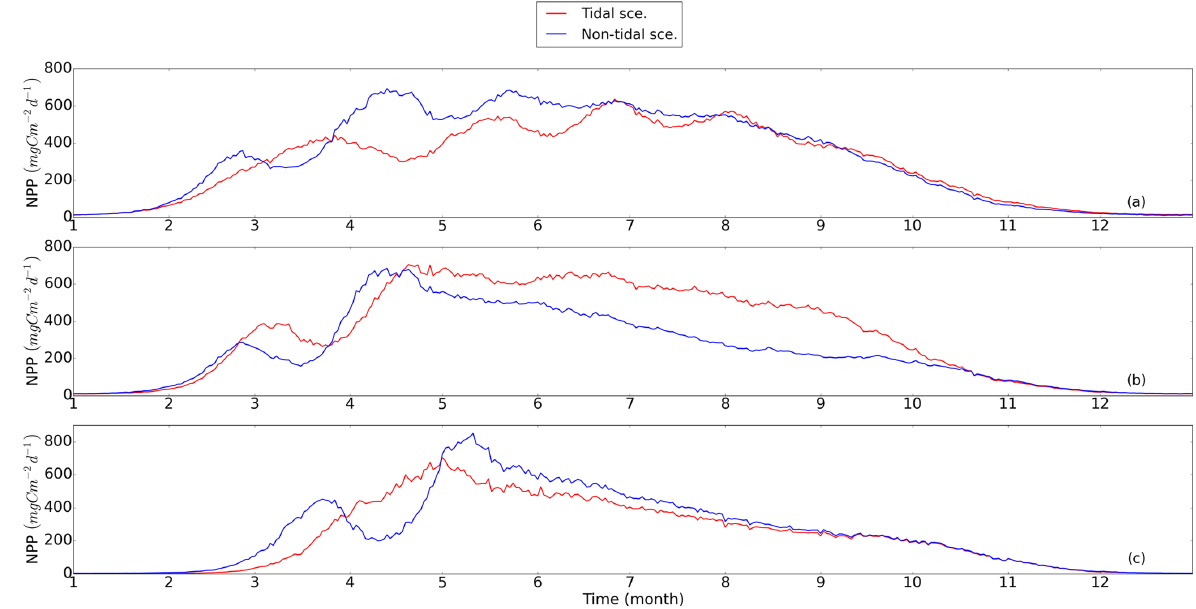
Figure 5. Time series of averaged NPP (blue: non-tidal scenario, red: tidal scenario) in subdomains; (a) neg. SNS: negatively responding southern North Sea, (b) pos. SNS: positively responding southern North Sea and (c) deep NNS: deeper northern North Sea. The NPP is averaged for the analyzed period